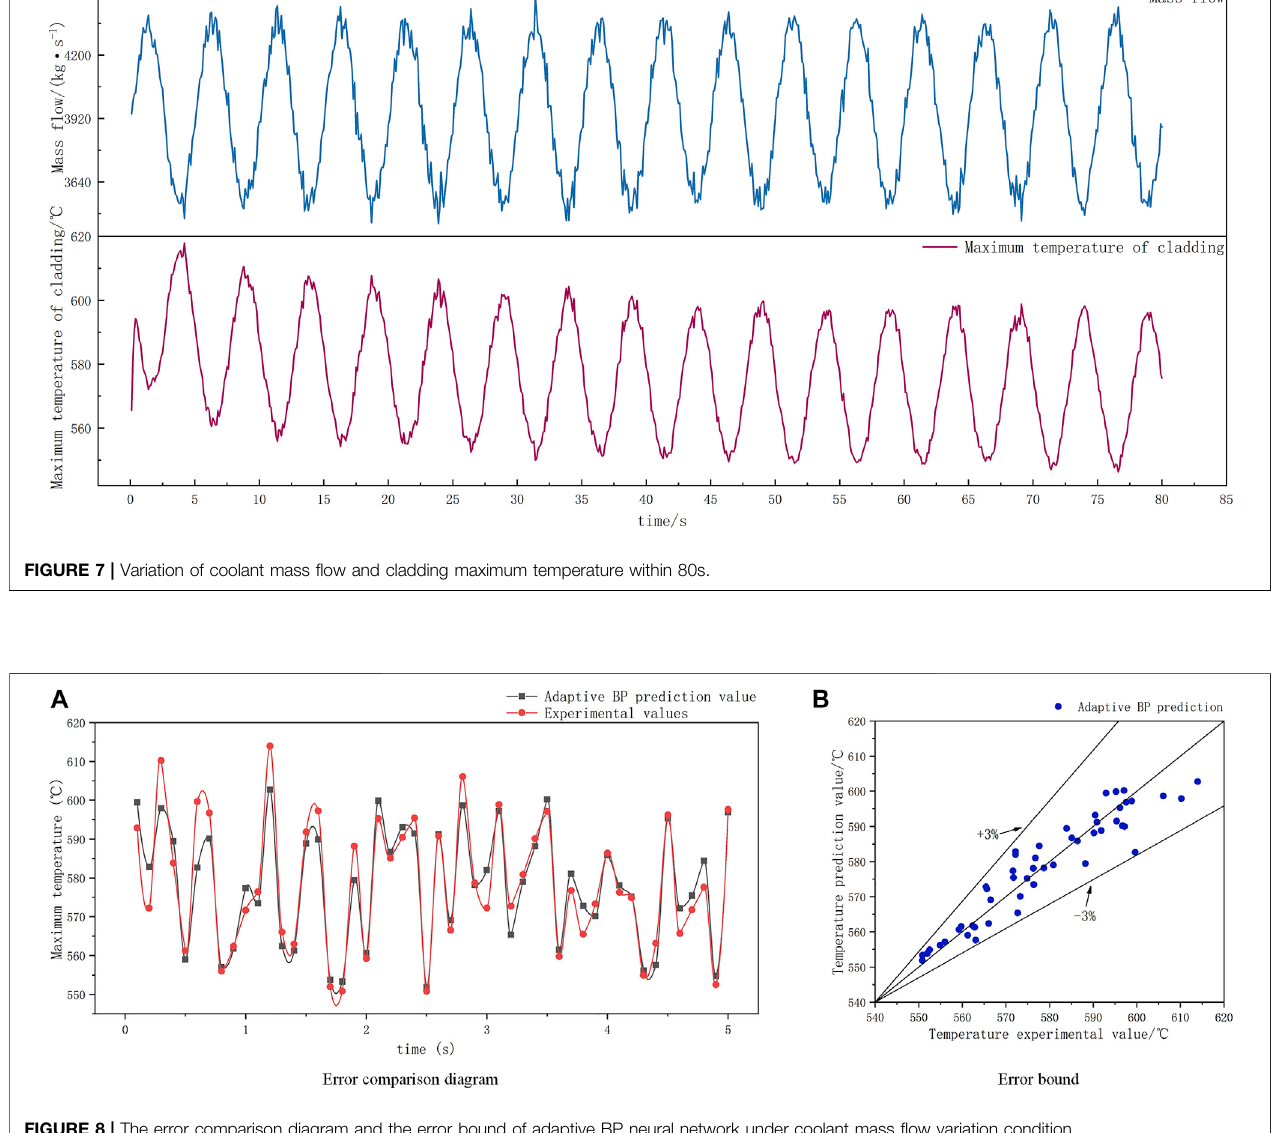
Frontiers in Energy Research |